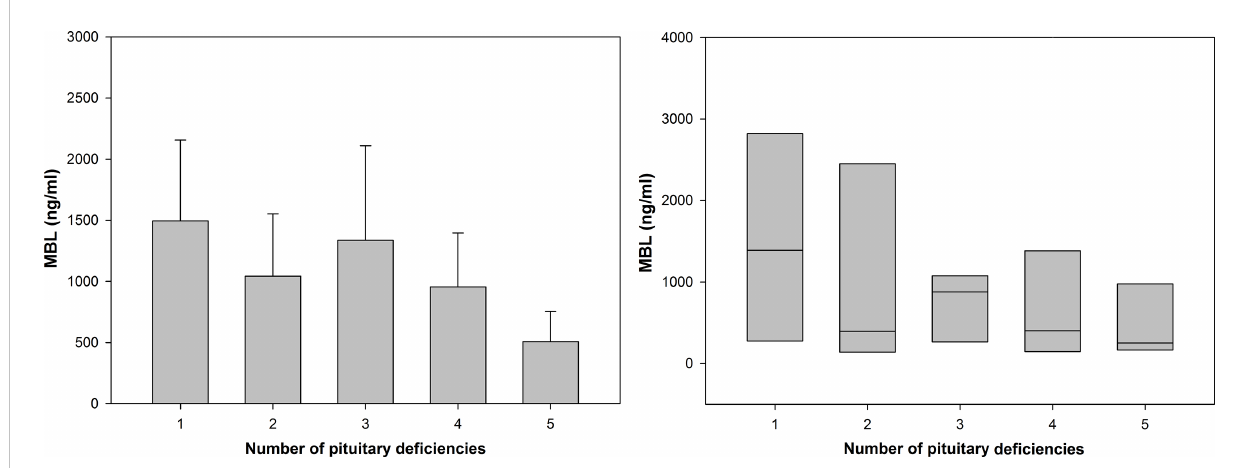
FIGURE 5 Bar chart of mean (± SEM) (left graph) and box plot of median (± SEM) (right graph) values of mannan-binding lectin (MBL) level in patients with hypopituitarism who are on inadequate replacement therapies (non-compensated hypopituitarism) presented in particular subgroups of individuals depending on how many pituitary axes are involved. Central line of each box denotes the median, the top and bottom edges of the box show the 25% and 75% percentile. No statistically signi fi cant differences were found.